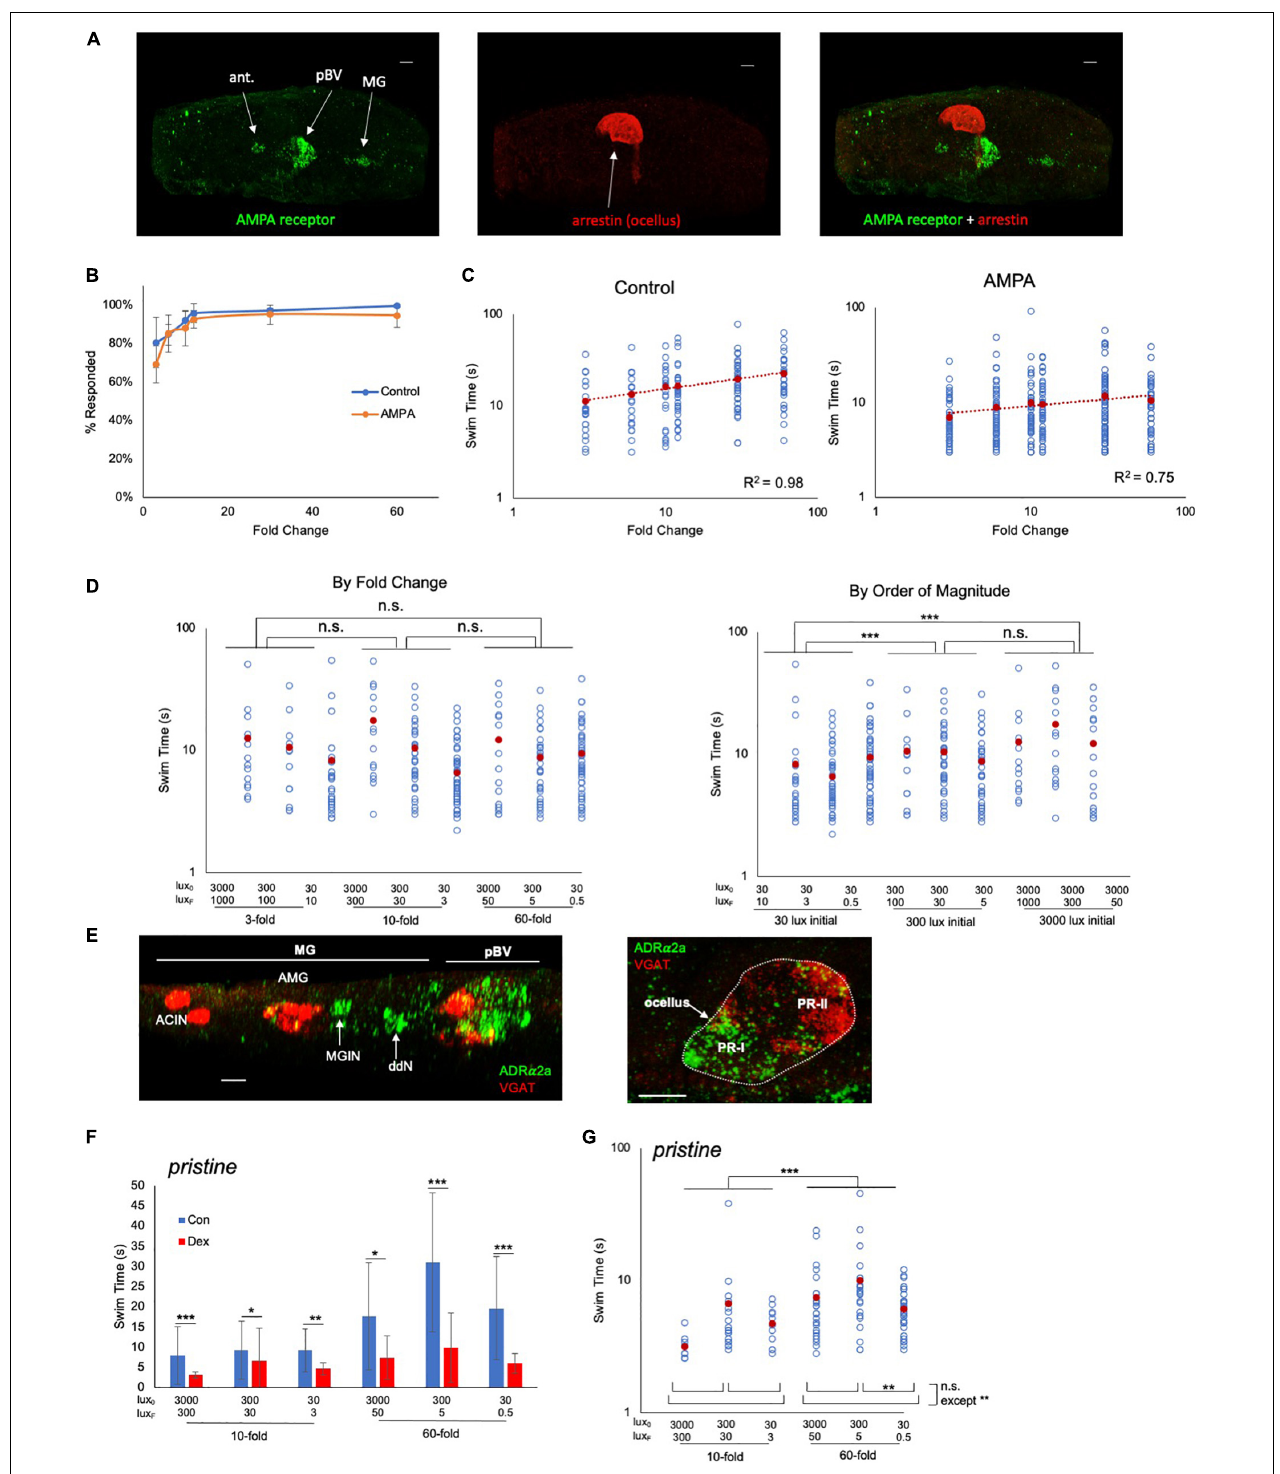
FIGURE 4 | Pharmacological modulation of behavioral responses. (A) AMPA receptor expression detected by in situ hybridization (green; left panel). Photoreceptors were detected by immunostaining for Arrestin detected by immunostaining (red; middle panel). Dorsal view, anterior to left. Right panel shows a merged view. Scale bars are 10 µ m. (B) Percentage of control and AMPA-treated larvae responding to the indicated fold change light dimmings series. The averages from three recordings are shown (+ S.D.). (C) Swim times of control and AMPA-treated larvae in the indicated fold change dimming series. The R 2 valves for the curves are indicated. (D) AMPA-treated larvae do not show scale-invariance to fold-change dims of different magnitudes (left panel; compare to controls in Figure 3A ). Right